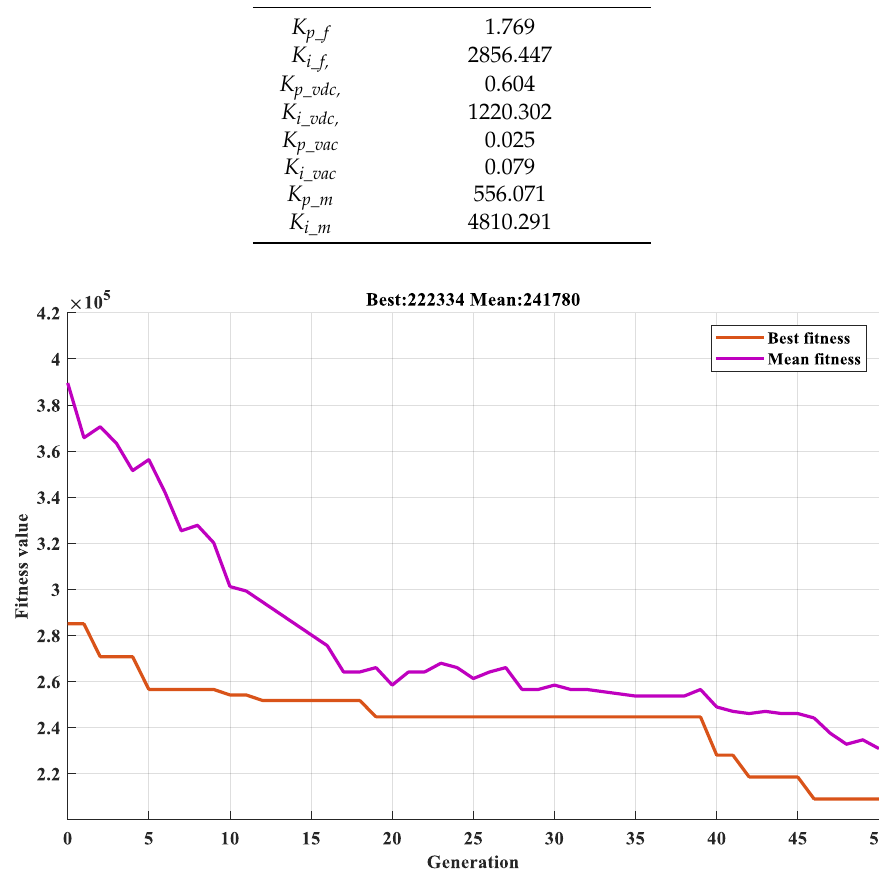
Figure 9. Convergence performance of the proposed algorithm.